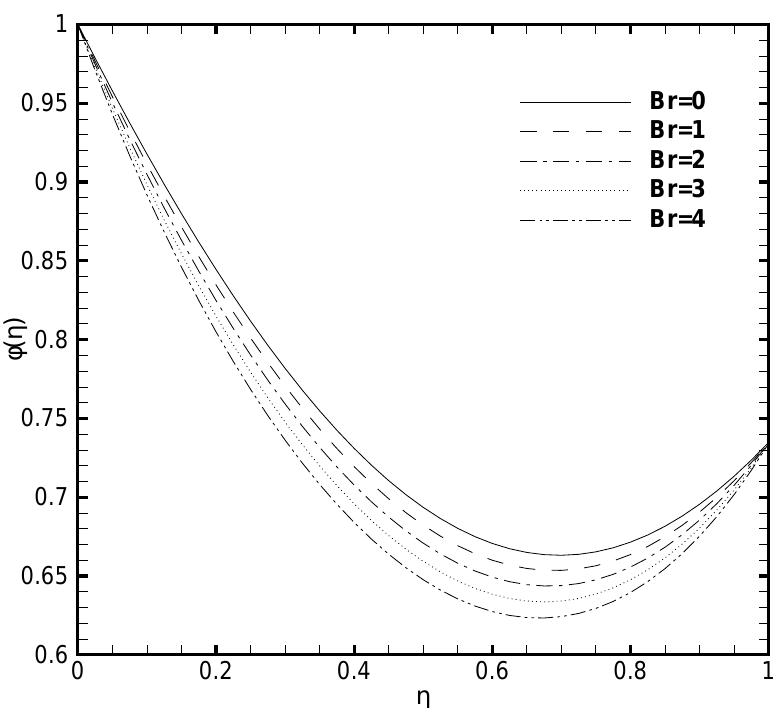
Figure 6. Nanoparticles concentration profile φ ( η ) for several values of Brinkmann number Br when ζ = P = κ = Ha = δ θ 2 = F k = 1, N b = 0.2, N t = 0.1, β = 0.05 and δ θ 1 = 0.5.